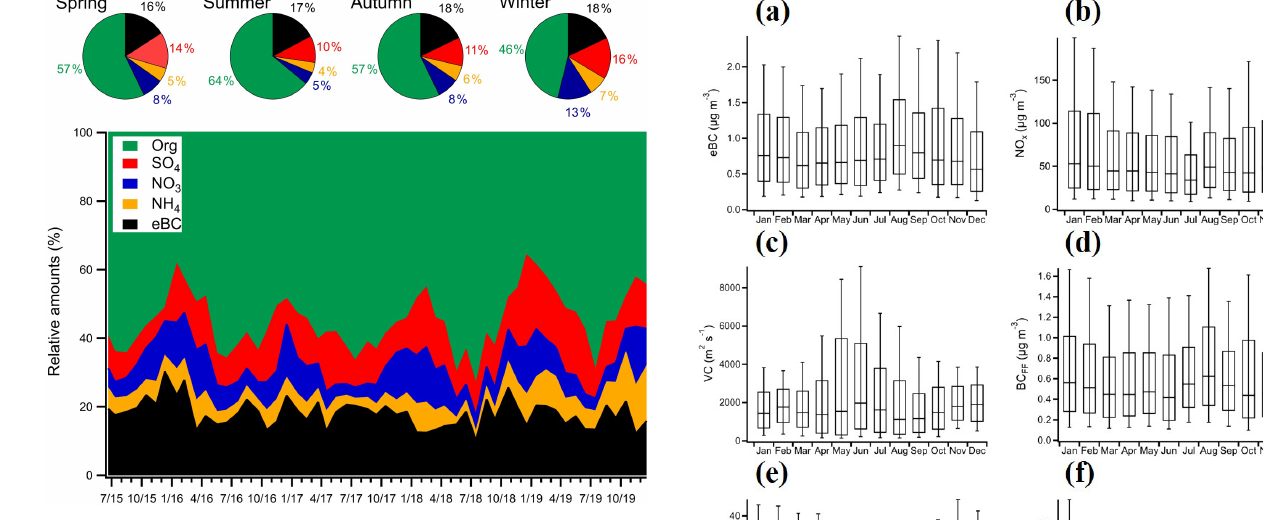
Figure 3. Time series of the PM 1 species monthly median mass fractions measured by ACSM (Org, SO 4 , NO 3 , NH 4 ) and MAAP (eBC). Pie plots represent the relative contribution of each species during different seasons of the year (spring (March–May), sum- mer (June–August), autumn (September–November), and winter (December–February)).